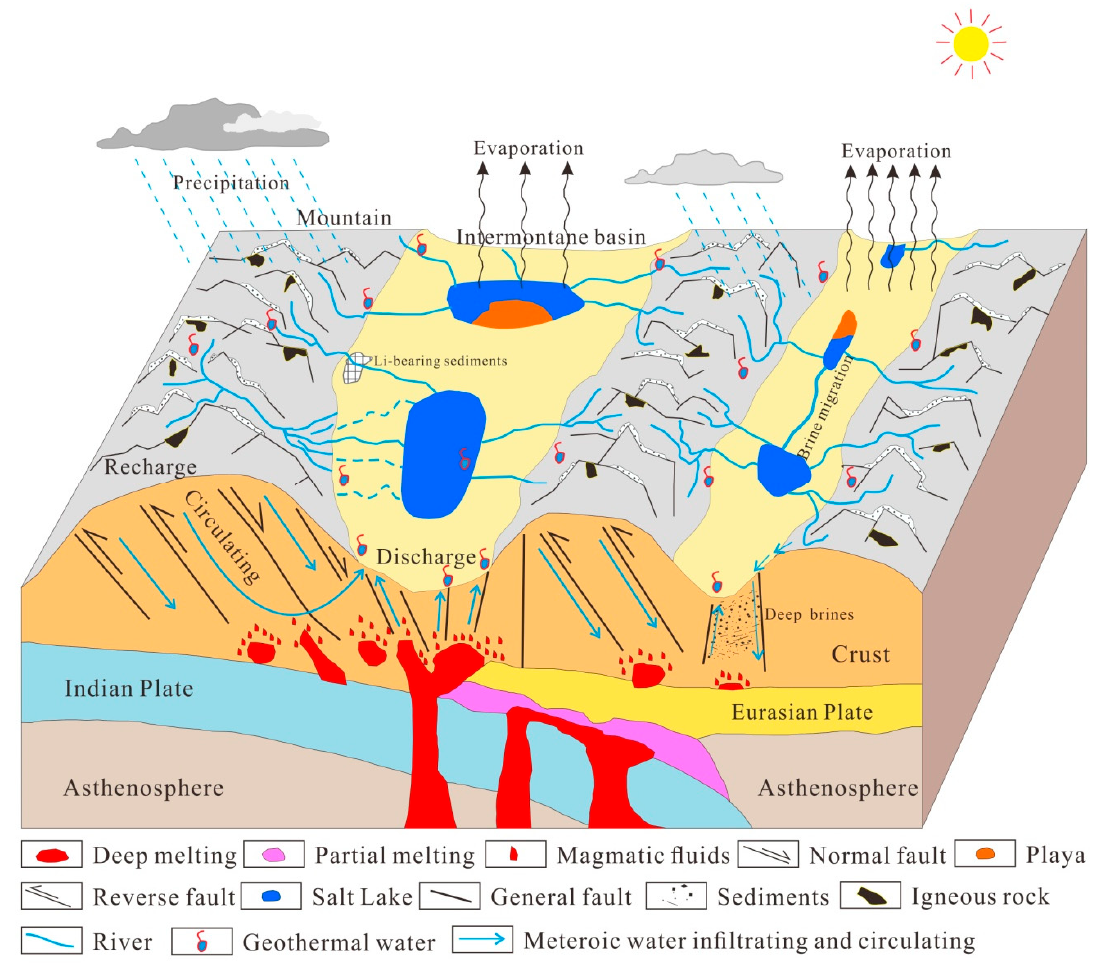
Figure 4. Schematic model for the formation of Li-rich brines in salt lakes on the Qinghai-Tibetan Plateau (after [78]).